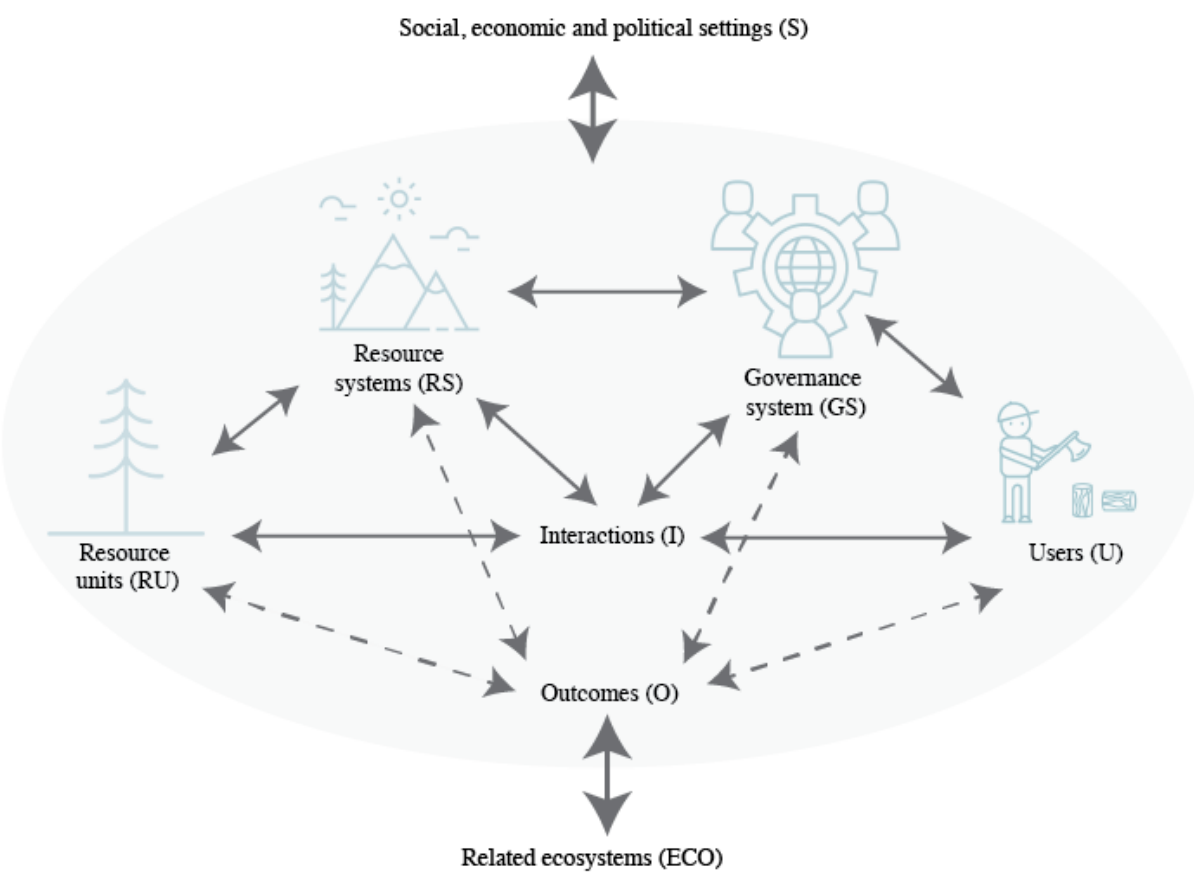
Figure 2. The core subsystems and their interactions in a framework to analyse socio-ecological systems. Adapted from Ostrom, 2009.